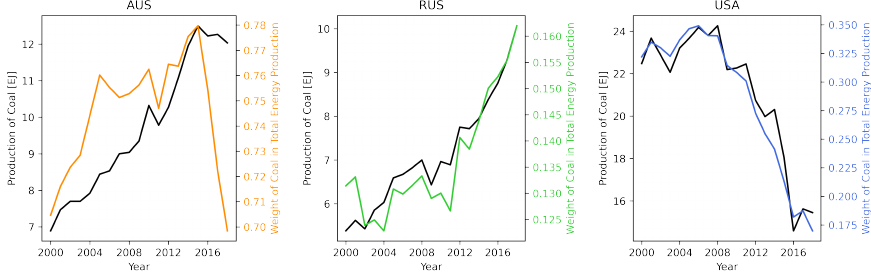
Figure 21. The evolution of coal production and its share in the total energy mix.